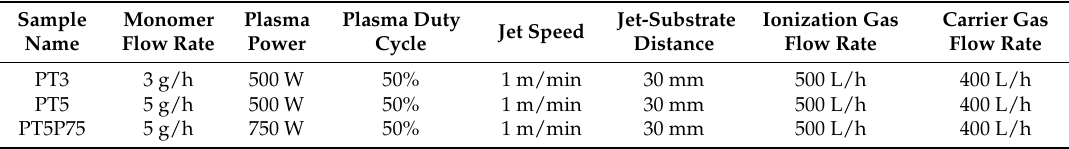
Figure 2. Surface structure of the aluminum surface after pre-treatment [38]. This structure is used as the substrate for deposition of organosilicon based coatings. Table 1. Plasma conditions used for preparation of samples.